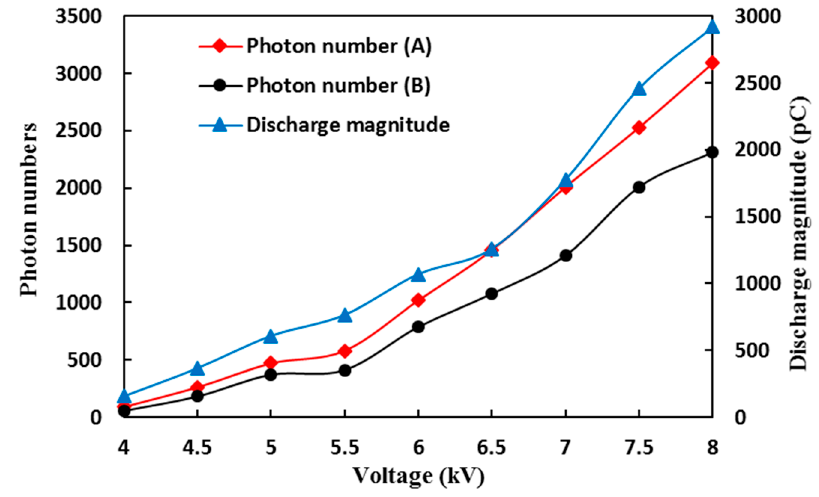
Figure 6. Test results of photon numbers and discharge magnitude ( p = 97.98 kPa; T = 20.3 °C; RH = 62.7%).